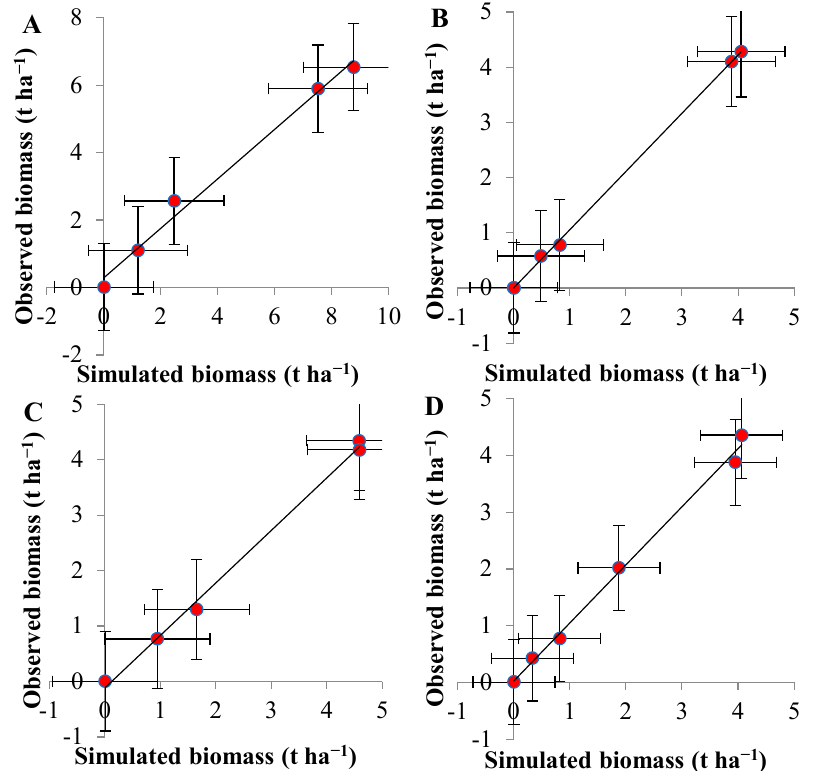
Figure 6. Evaluation of simulated biomass for oilseed flax for the studies conducted in Dingxi ( A ); Zhangjiakou ( B ); Wulanchabu ( C ); and Datong ( D ).